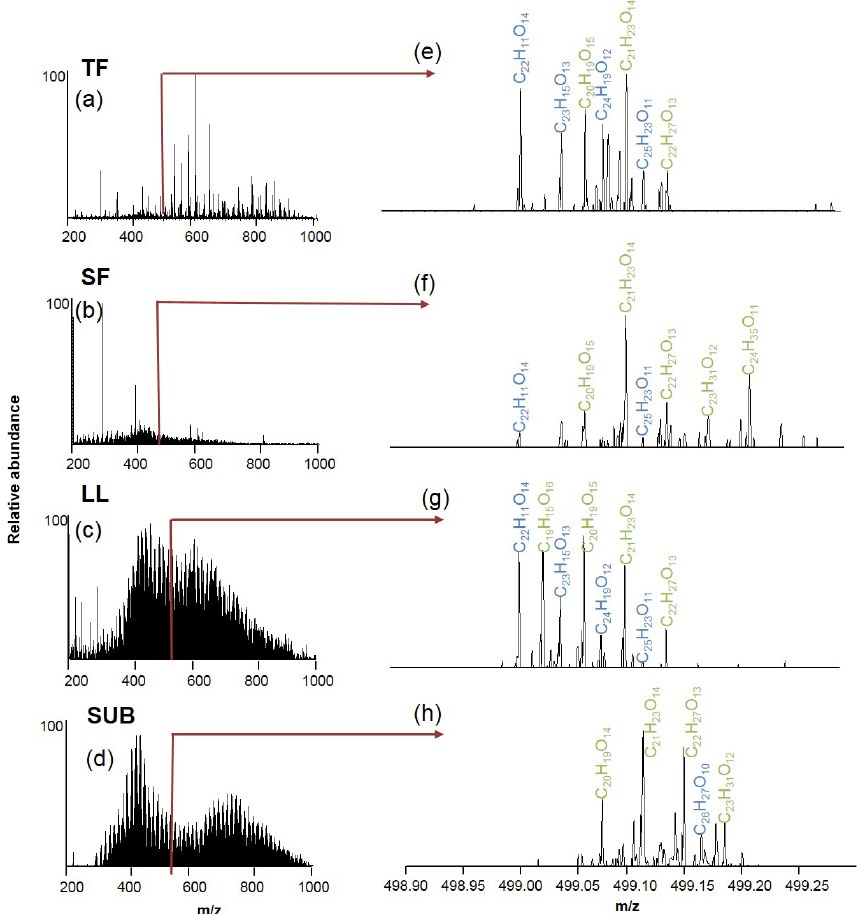
Figure 3. Electrospray ionization Fourier transformation ion cyclotron resonance mass spectra (ESI-FT-ICR-MS) of coniferous (pine) age- class forest samples from the Schorfheide (a–d) and details for m/z 499 (e–h) . Assigned molecular formulae are in green and blue. TF: throughfall; SF: stemflow; LL: litter leachate; SUB: subsoil